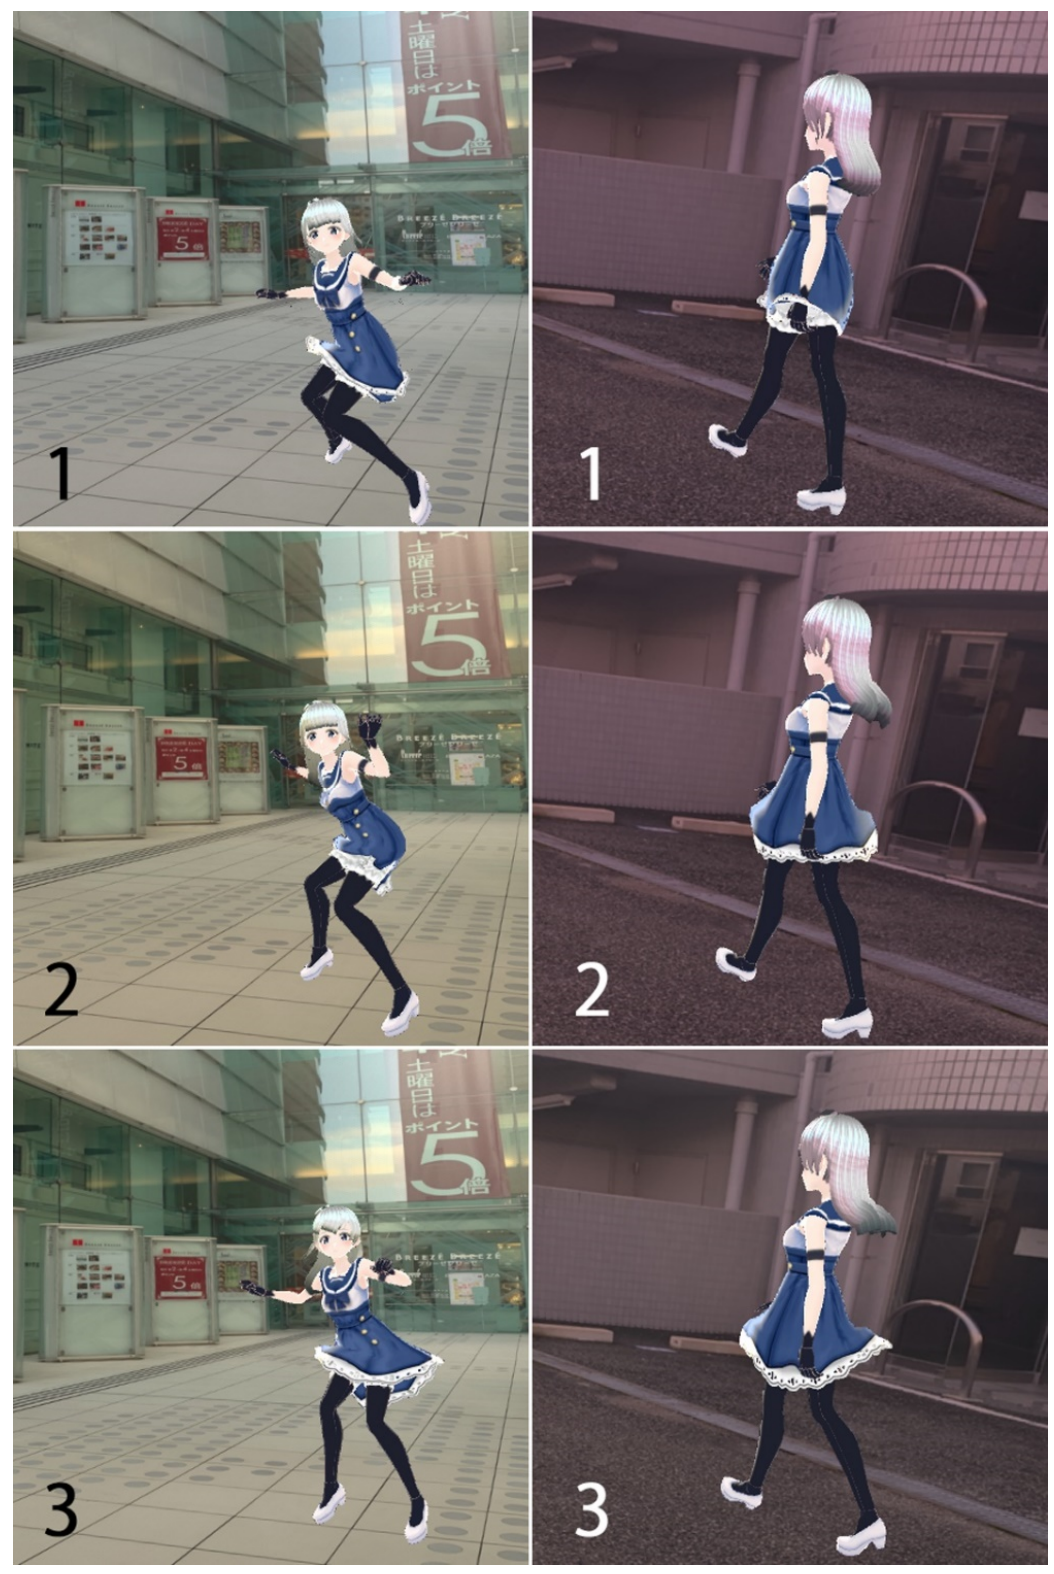
Figure 1. Sample of the input training data for deep learning. The three consecutive images on the left (black 1–3) are dancing movements, and those on the right (white 1–3) are walking movements.